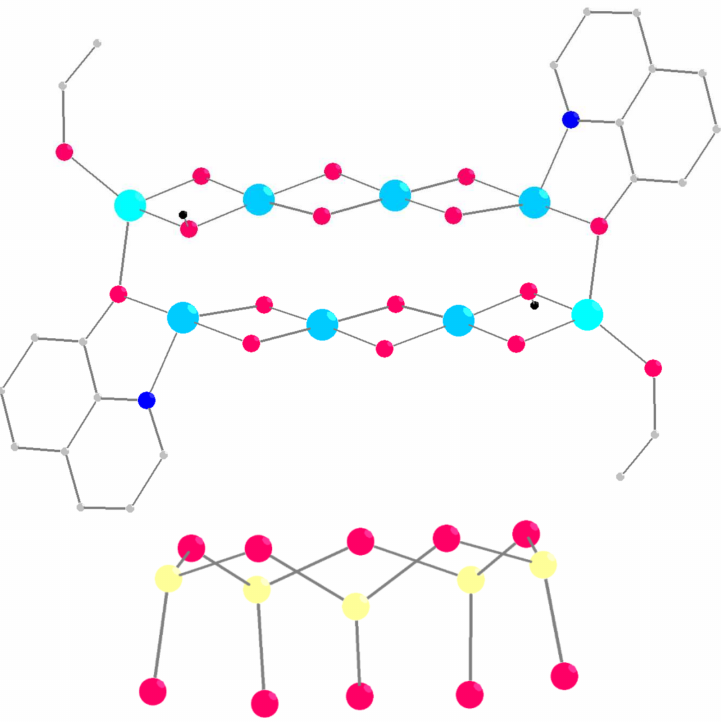
Figure 2. Top . The metal-containing central core of 1 . Bottom . The silsesquioxane ligand of 1 . Phenyl groups at the silicon atoms are not shown. The color code is the same as in Figure